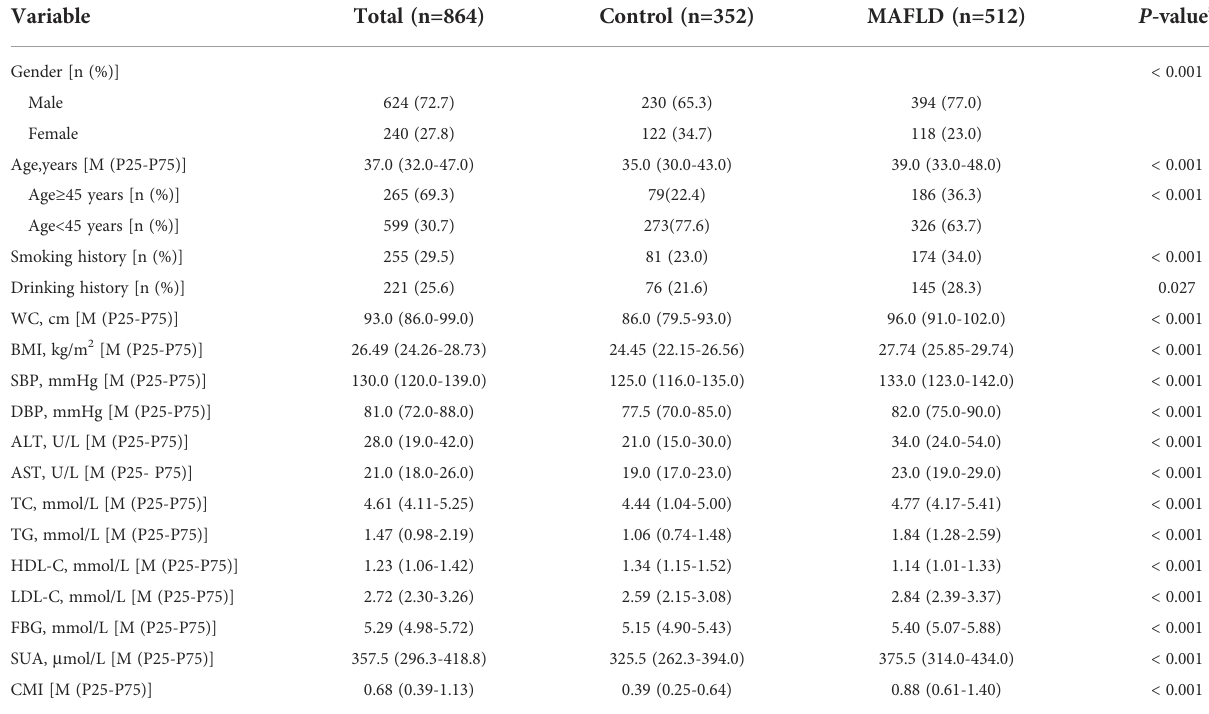
TABLE 1 Baseline characteristics of the MAFLD group and control